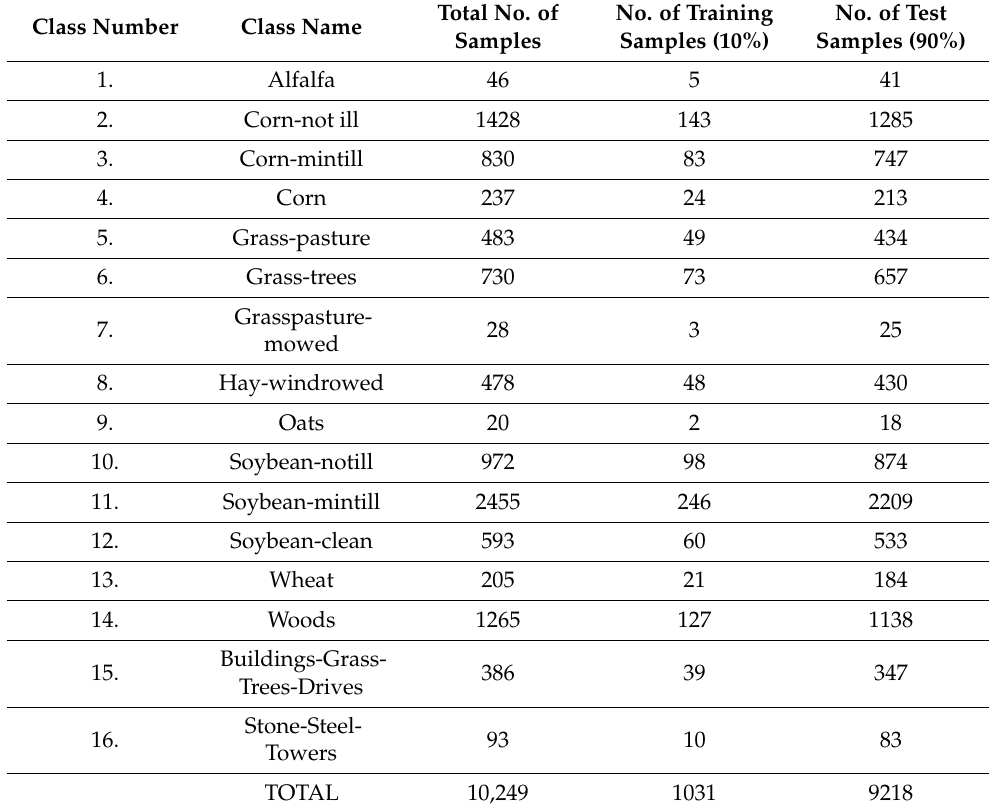
Figure 6. ( a ) Indian Pines dataset map; ( b ) color codes with scale bar (* is approximate scale of dataset). Table 2. Training and test samples of Indian Pines